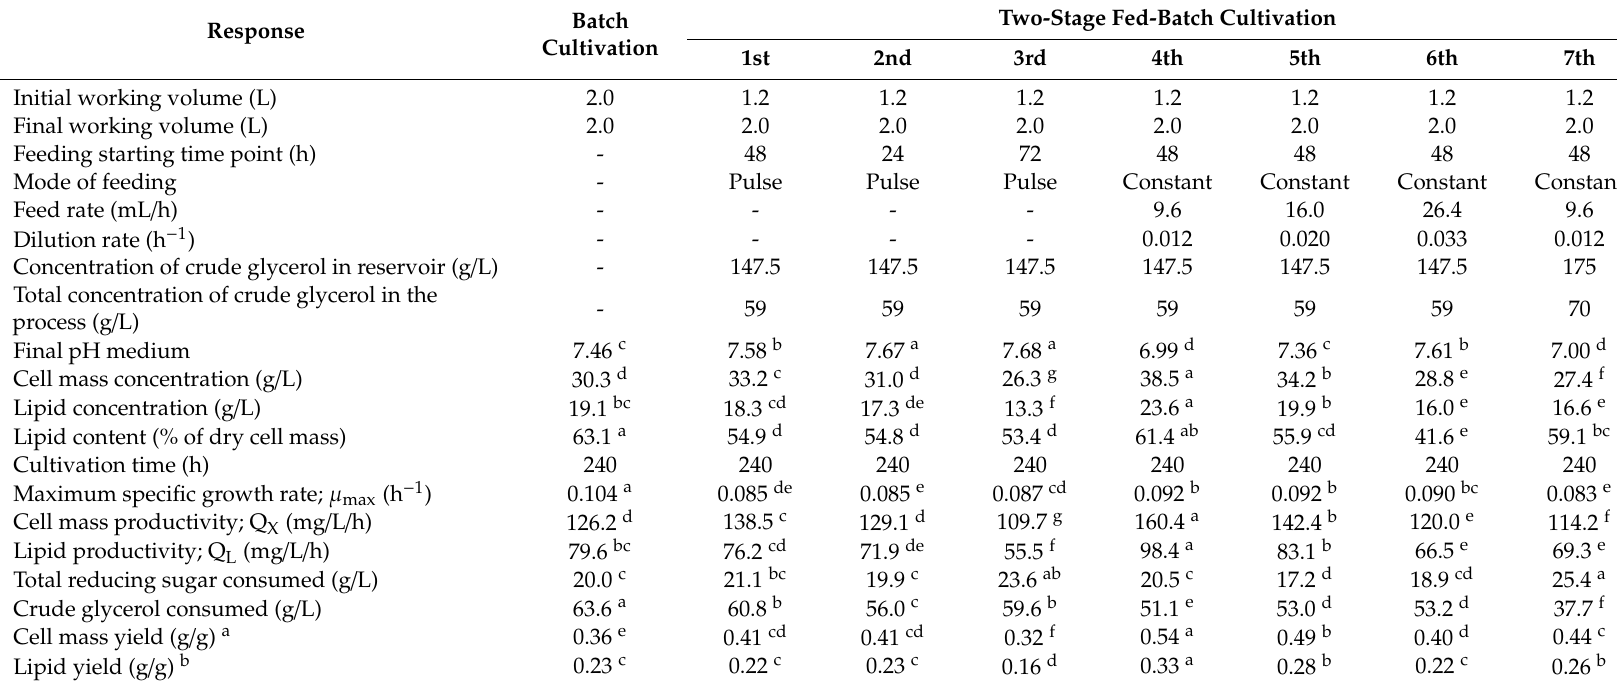
Table 2. Comparison of cell mass and lipid production by Rhodosporidiobolus fluvialis DMKU-SP314 using batch and two-stage fed-batch cultivations with di ff erent feeding